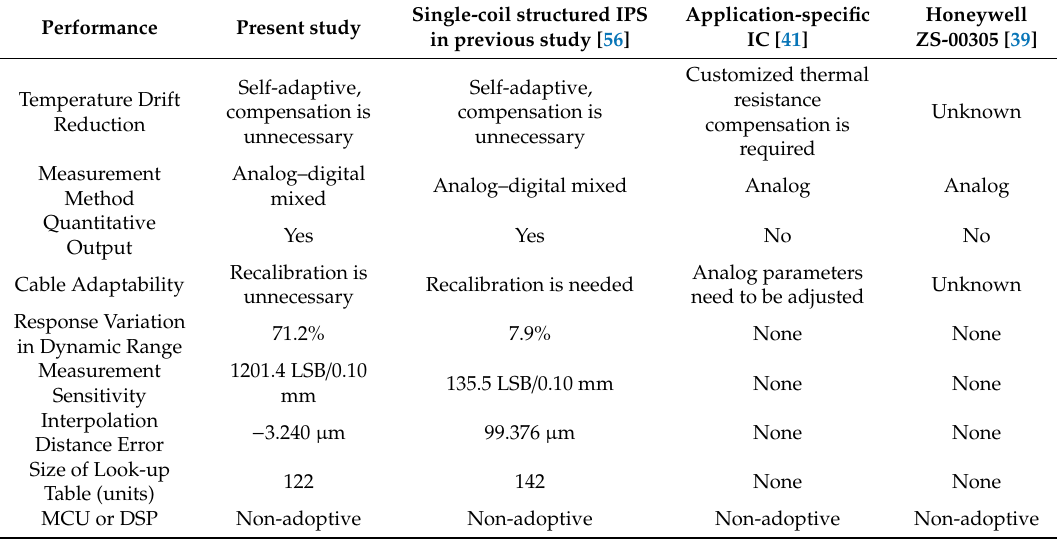
Table 5. Comparison of the present study with related works. IC—integrated circuit; MCU—micro- controller unit; DSP—digital signal